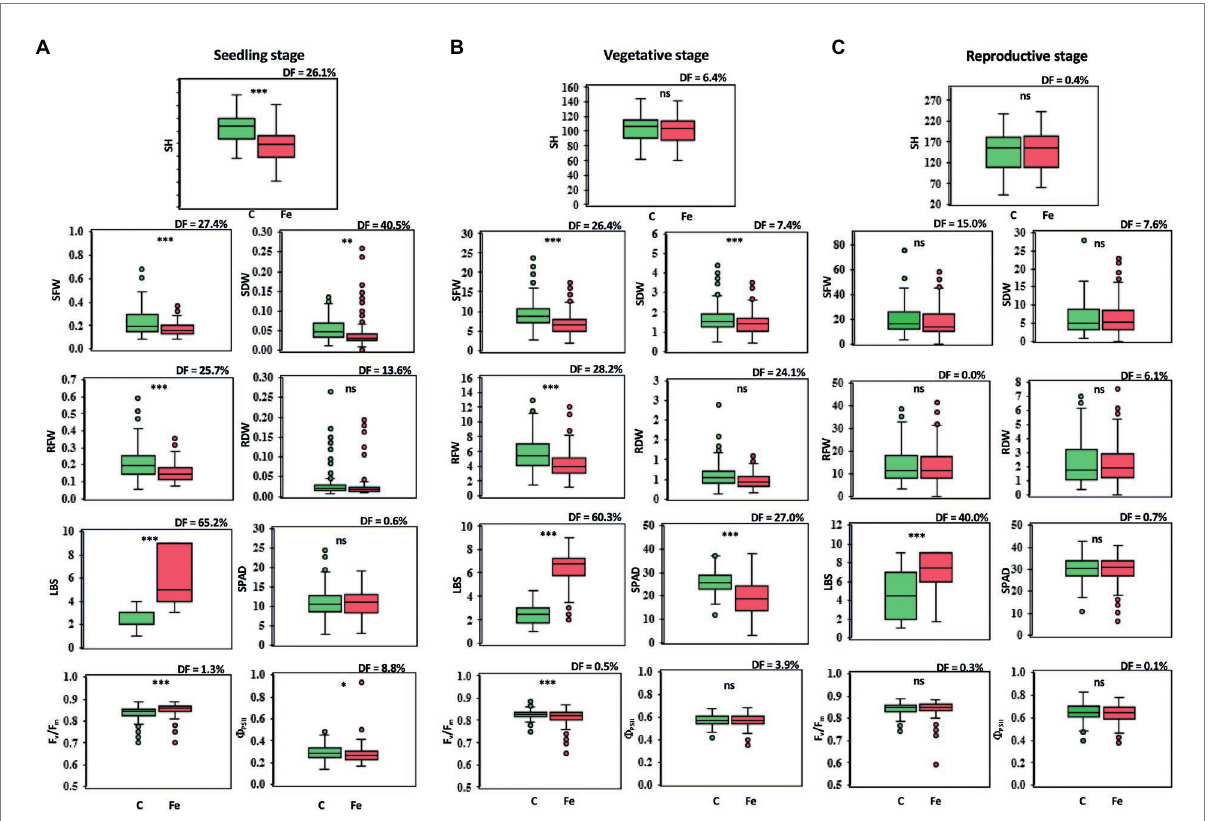
FIGURE 1 Trait variations at the seedling (A) , vegetative (B) , and reproductive stages (C) , comparing control (C) and iron toxicity (Fe) conditions. SH, shoot height (cm); SFW, shoot fresh weight (g plant − 1 ); SDW, shoot dry weight (g plant − 1 ); RFW, root fresh weight (g plant − 1 ); RDW, root dry weight (g plant − 1 ); LBS, leaf bronzing score; SPAD, leaf greenness index; F v /F m , maximum quantum yield of PSII; Φ PSII , photon yield of PSII. *, **, *** and ns mean data of C and Fe are significant different at p < 0.05, 0.01, 0.001 and non-significant,